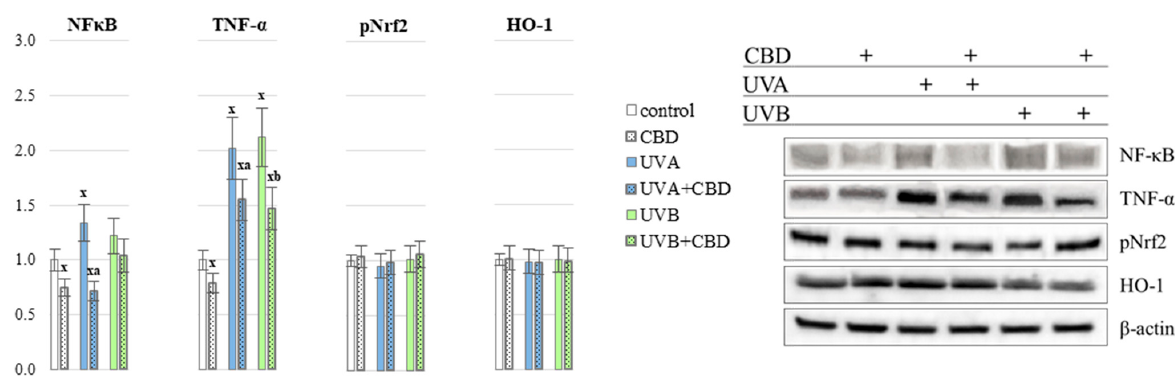
Figure 6. The level of NF- κ B (p52) and product of its transcriptional activity—TNF- α as well as phospho-Nrf2 (p68) and product of its transcriptional activity—HO-1 in nude rats PMNs in the following groups: control; treated with CBD (every 12 h) for 4 weeks; irradiated with UVA (every 48 h) for 4 weeks; irradiated with UVA (every 48 h) and treated with CBD (every 12 h) for 4 weeks; irradiated with UVB (every 48 h) for 4 weeks; irradiated with UVB (every 48 h) and treated with CBD (every 12 h) for 4 weeks. The mean values for six rats in each group ± SD are shown: x—differences vs. control group, p < 0.05; a—differences vs. UVA treated group, p < 0.05; b—differences vs. UVB treated group, p < 0.05.